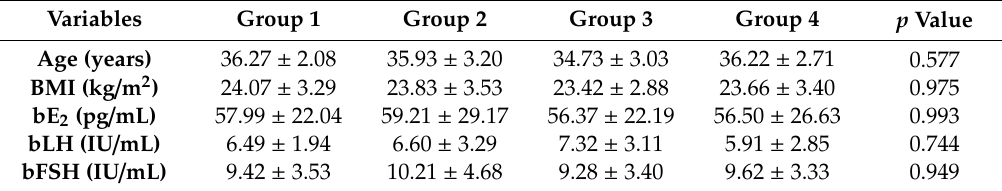
Table 1. Baseline features of participants enrolled in the